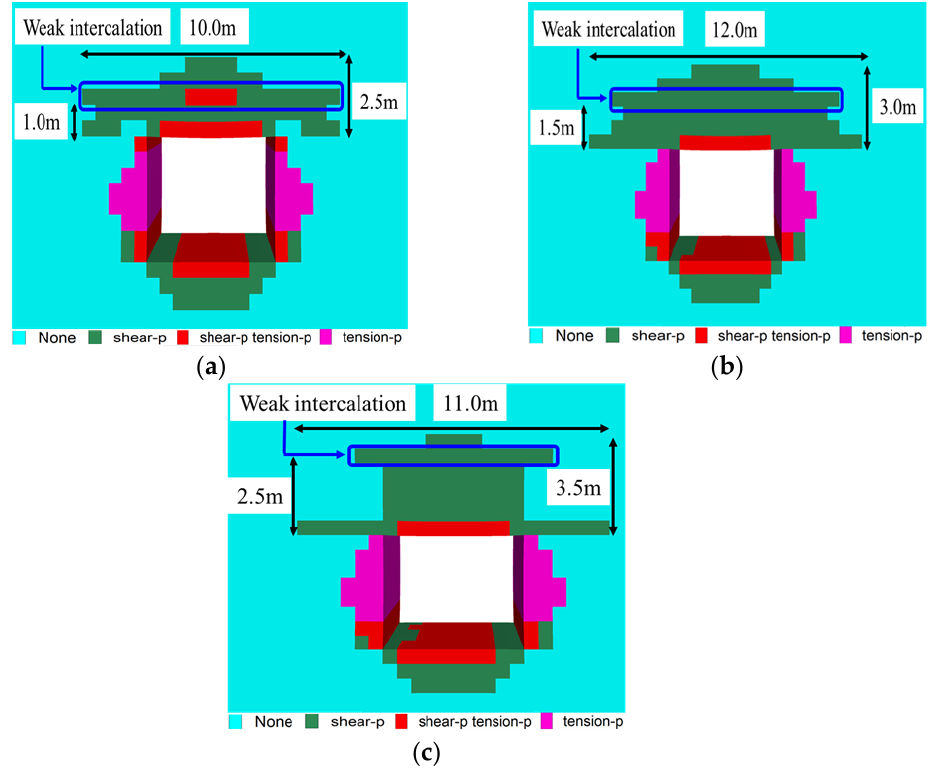
Figure 10. Simulation Results of Scheme V. ( a ) Scheme V — 0.5 times L . ( b ) Scheme V — 0.8 times L . ( c ) Scheme V — 1.0 times L .